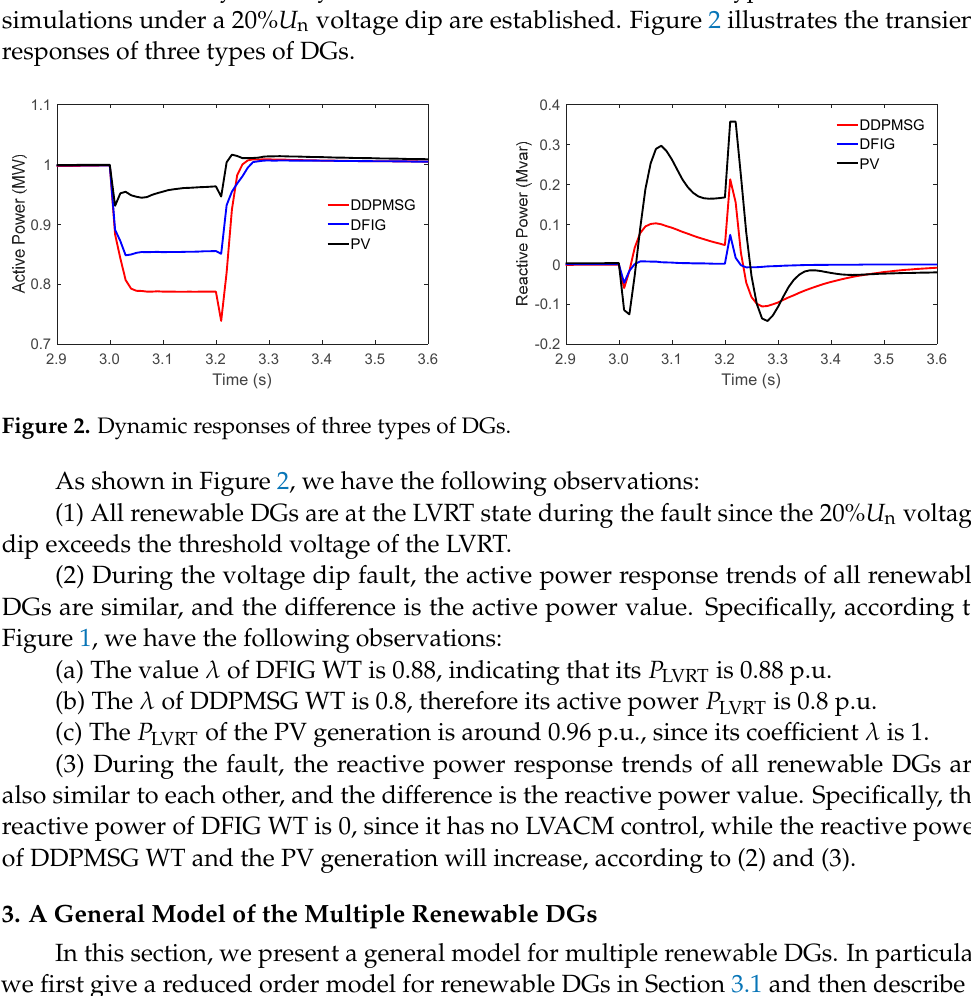
Figure 1. Low-voltage active power management. Under the mode of the reactive power priority control, the active current during the LVRT can be expressed as follows,